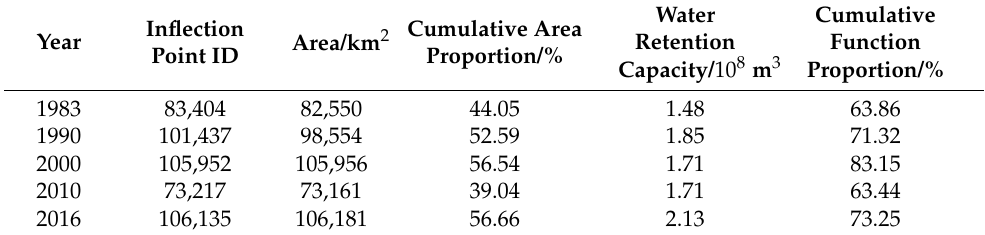
Table 4. Evaluation results of water conservation function in Jilin